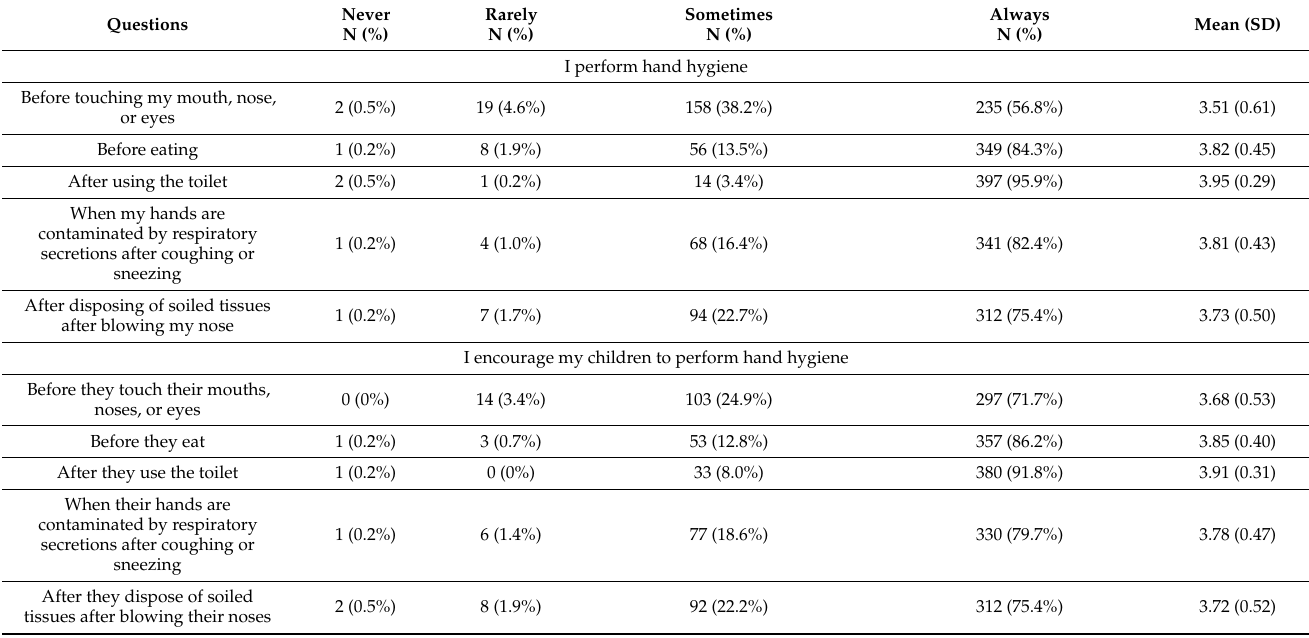
Table 5. Parental hygiene practices for URTI prevention in their